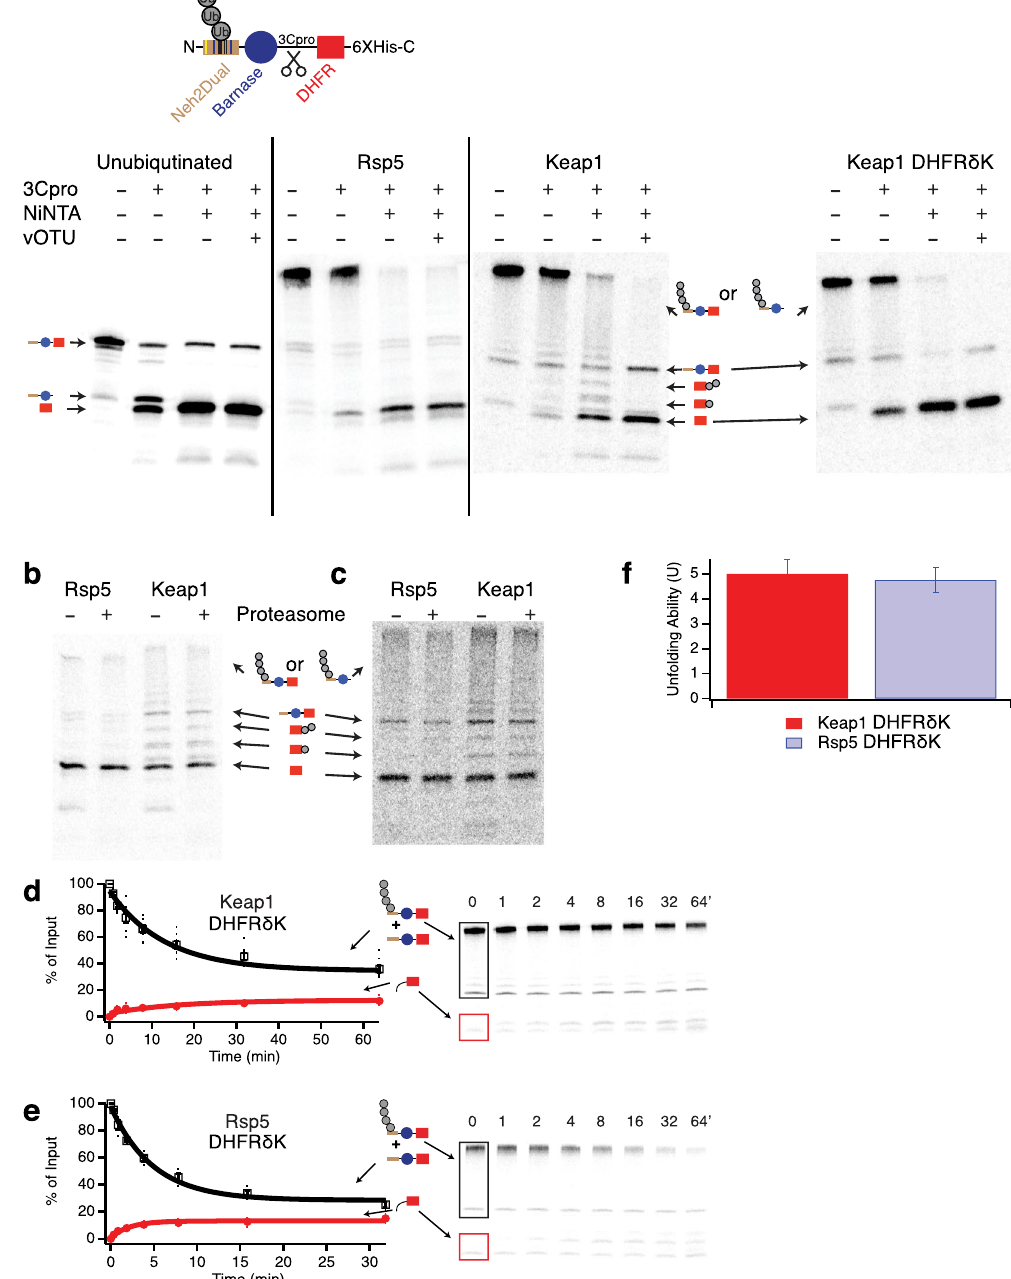
Figure 6. Keap1 substrates are internally mono- and di-ubiquitinated on the DHFR domain. ( a ) Neh2Dual- BarnaseL89G-3Cpro-DHFR-His or Neh2Dual-BarnaseL89G-3Cpro-DHFR δ K-His was ubiquitinated (or left unubiquitinated), cleaved with HRV 3C protease, and then repurified on NiNTA magnetic beads. After elution, the sample was either treated or mock-treated with vOTU to remove any ubiquitins on the DHFR domain. DHFR δ K sample was ubiquitinated in the presence of 500 µ M NADPH. Lines indicate separate gels. ( b ) The purified DHFR fragment from A was incubated with 100 nM wild-type proteasome for 1 hr at 30 °C. There was no change in intensity of any of the DHFR bands, indicating that these DHFR fragments are not degraded or deubiquitinated by the proteasome. ( c ) As in B, except substrate was Neh2Dual-BarnaseL89G-3Cpro-35 ∆ K- DHFR-6XHis, such that the purified fragment contained an unstructured initiation site. There was no change in intensity of any of the DHFR bands, indicating that these DHFR fragments are not degraded or deubiquitinated by the proteasome. Cleavage was less efficient with this construct, resulting in higher amounts of uncleaved material and less fragment. ( d , e ) Degradation of trace radiolabeled Keap1- ( d ) or Rsp5- ( e ) ubiquitinated Neh2Dual-BarnaseL89G-3Cpro-DHFR δ K-His by 100 nM wild-type proteasome. Black box shows region of the gel containing full-length protein with or without ubiquitination. Red box shows the region of the gel containing the DHFR fragment. The amounts of full-length protein (open squares) and DHFR fragment (red circles)